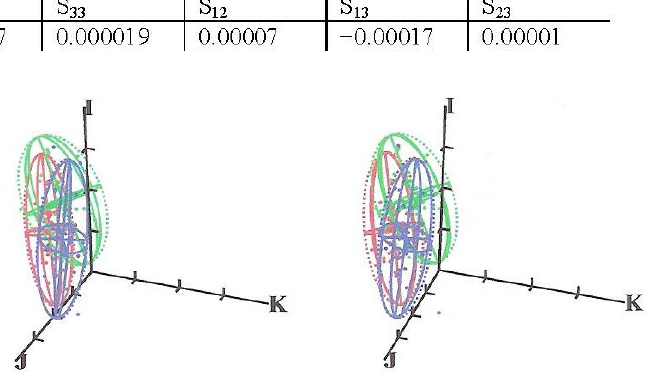
Figure 2: Stereo-pair scatter plot of fifty measurements of re- fractive state taken from subject 1. The origin of the axes is at − 1 I D. Red, green and blue data points represent measurements taken before, after ten minutes and after thirty minutes of lens wear respectively (this applies to all scatter plots in this article).